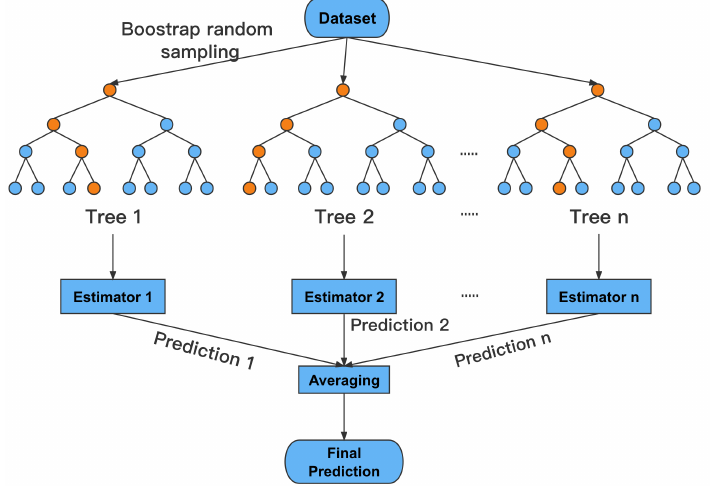
Figure 3. Schematic diagram of RF.